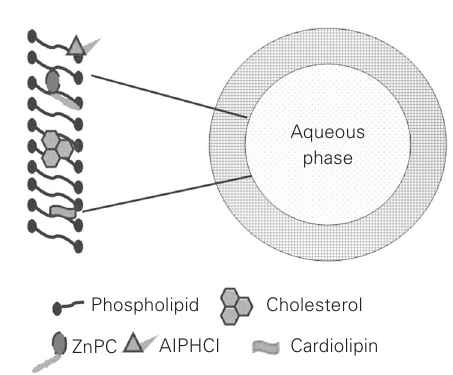
Figure 6. Preferential locations of the photosensitizers ZnPC and AlPHCl in mixed liposomes of